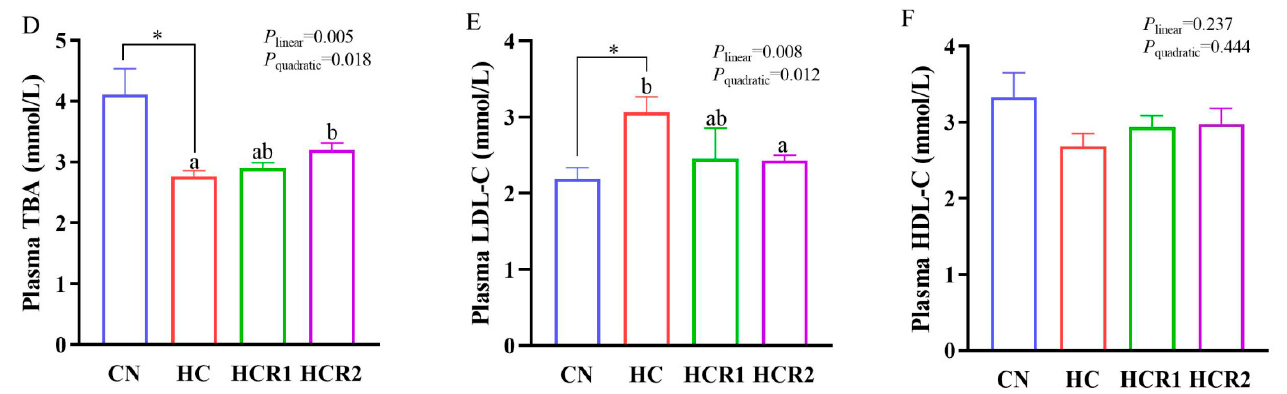
Figure 2. Plasma concentrations of glucose ( A ), TC ( B ), TG ( C ), TBA ( D ), LDL-C ( E ), and HDL-C ( F ). Each data point represents the mean of four replicates (4 individuals per replicate). * Means p < 0.05, compared between the control and the HC group. ab Compared among the HC, HCR1, and HCR2 groups. Bars assigned with different superscripts are significantly different ( p < 0.05). Control, diet with 32% nitrogen-free extract; HC, diet with 45% nitrogen-free extract; HCR1, diet with 45% nitrogen-free extract and 0.04% resveratrol; HCR2, diet with 45% nitrogen-free extract and 0.08% resveratrol. TC, total cholesterol; TG, total triglycerides; TBA, total bile acid; HDL-C, high-density lipoproteins cholesterol; LDL-C, low-density lipoproteins cholesterol.